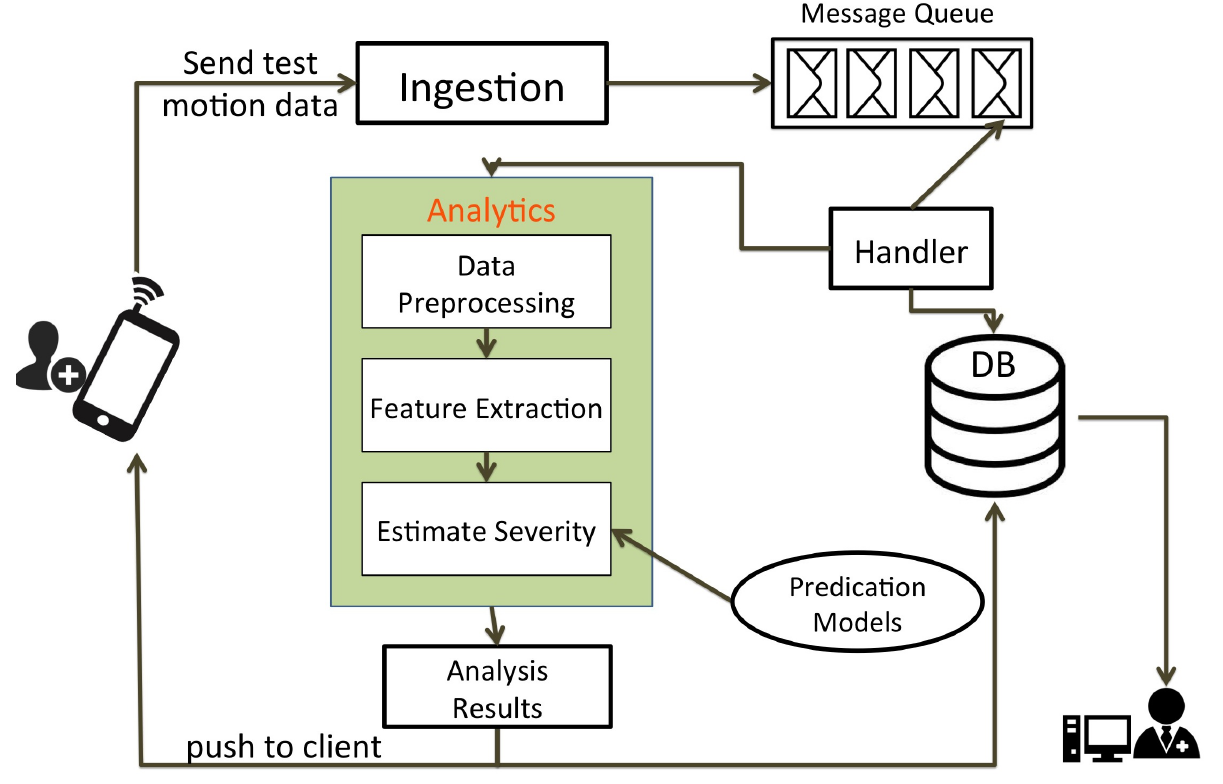
Figure 1. System architecture and data communication flow.